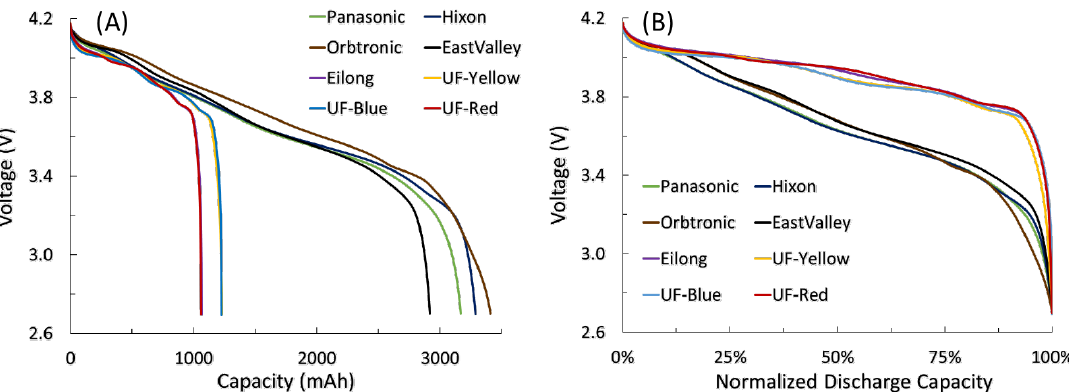
Figure 3. ( A ) Discharge voltage profile at C/10 rate and ( B ) normalized discharge voltage profile for one cell of each type discharged at a C/10 rate.